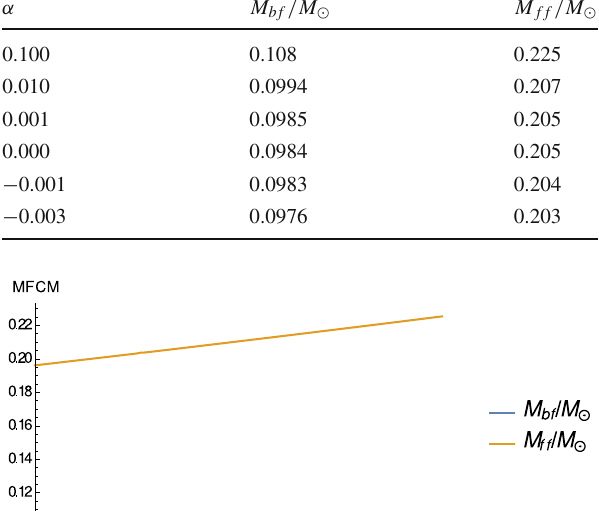
Table 2 Numerical values for the MFCM (in solar mass units), using the total bound-free and the free-free opacities, defined in Eqs. (69) and (70), respectively, for different values of the composite EiBI parameter α appearing in Eq. (18) α M / M (cid:2) M / M (cid:2) bf f f